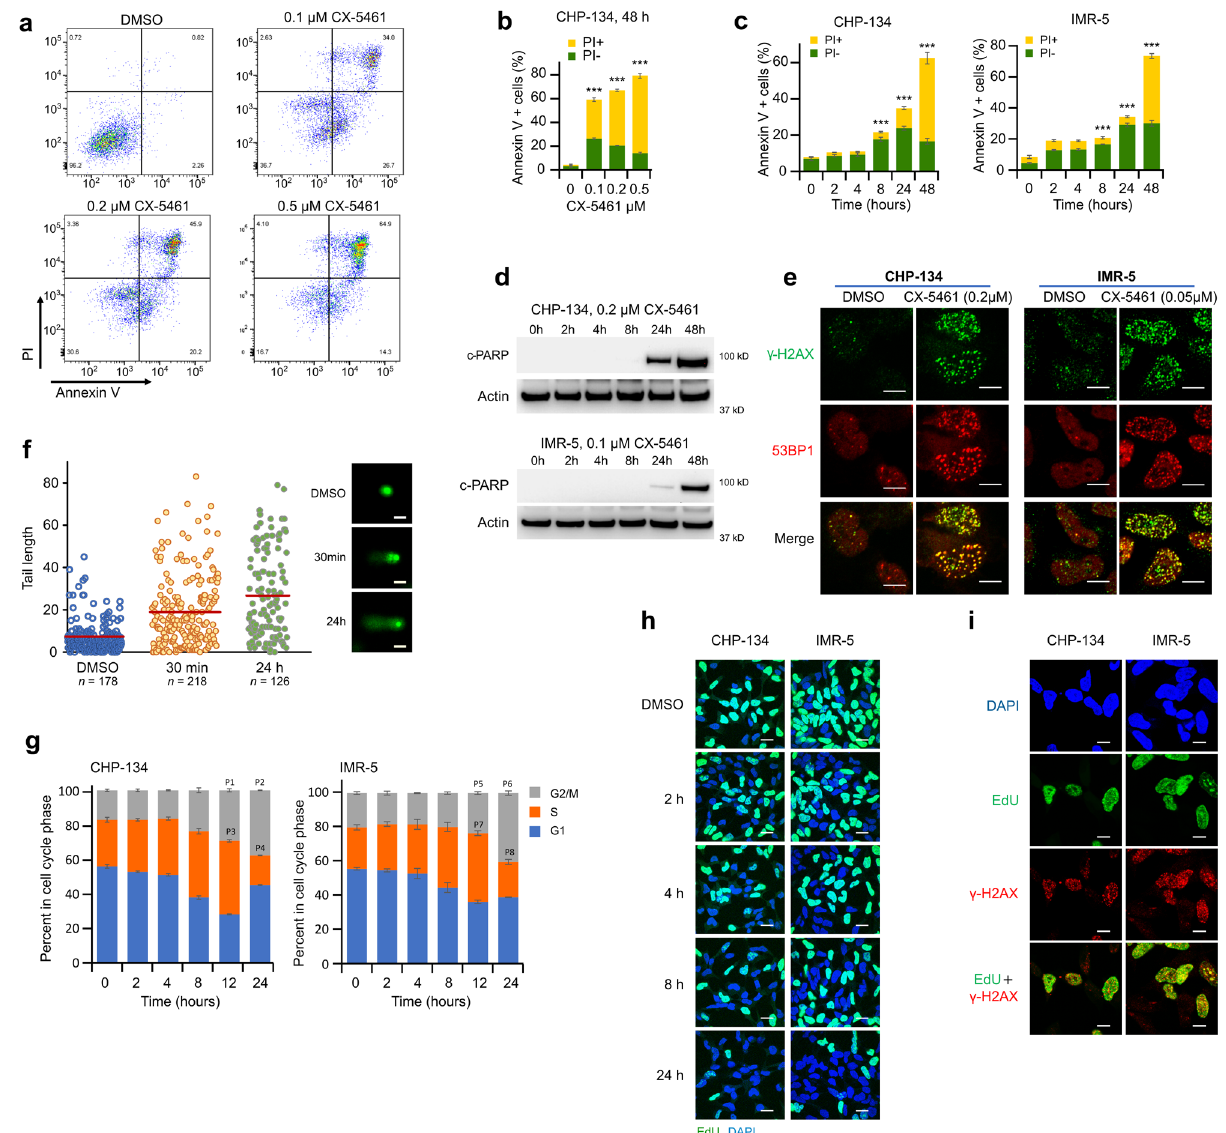
Fig. 3 CX-5461 causes DNA damage and cell death by apoptosis in neuroblastoma cells at sub-micromolar concentrations. a Apoptosis in CHP-134 cells. The cells were treated for 48 h. b Quanti fi cation of data in ( a ). Data represent the mean ± SD of three independent experiments. Signi fi cant P -values (left to right): 3.9 × 10 − 6 , 7.2 × 10 − 7 , and 4.8 × 10 − 7 . c Quanti fi cation of fl ow cytometry data showing apoptosis up to 48 h in CHP-134 and IMR-5 (0.2 µ M and 0.1 µ M of CX-5461 respectively). CHP-134 cells were treated with 0.2 µ M and IMR-5 cells with 0.1 µ M of CX-5461. Data represent the mean ± SD of three independent experiments. Signi fi cant P -values (left to right): CHP-134, 2.2 × 10 − 4 , 3.2 × 10 − 5 , and 1.5 × 10 − 5 ; IMR-5, 1.8 × 10 − 4 , 2.3 × 10 − 5 , and 2.5 × 10 − 6 . d Western blots for cleaved PARP (c-PARP). β -Actin was used as a loading control. Representative results of three biological replicates are shown. e Co-localization of 53BP1 and γ -H2AX. Cells were treated for 24 h. Representative results of three biological replicates are shown. Scale bar = 10 μ m. See Fig. S3d for more time points. f Comet assay in CHP-134 cells. Tail length (left) and representative images (right) are shown. The red line indicates the mean value of tail length in each group. Scale bar = 5 µ m. g Cell cycle analysis forCHP-134 (0.2 µ M CX-5461) and IMR-5 (0.05 µ M CX-5461) cells. Data represent the mean ± SD of three independent experiments. P -values vs 0 h: P1 = 4.2 × 10 − 5 , P2 = 7.1 × 10 − 7 , P3 = 6.3 × 10 − 5 , P4 = 2.7 × 10 − 4 , P5 = 6.3 × 10 − 3 , P6 = 2.3 × 10 − 5 , P7 = 1.8 × 10 − 4 , and P8 = 0.044. h EdU incorporation assay to assess global nascent DNA transcription. Representative results of three biological replicates are shown. Blue, DAPI; green, EdU. Scale bar = 20 µ m. i CX-5461 induced DNA damage ( γ -H2AX, red) was enriched in cells with active DNA synthesis (positive for EdU (green) labeling). Representative results of three biological replicates are shown. Scale bar = 10 μ m. Two-tailed t- test was used for ( b , c , g ). Source data for these panels are included in Source Data fi